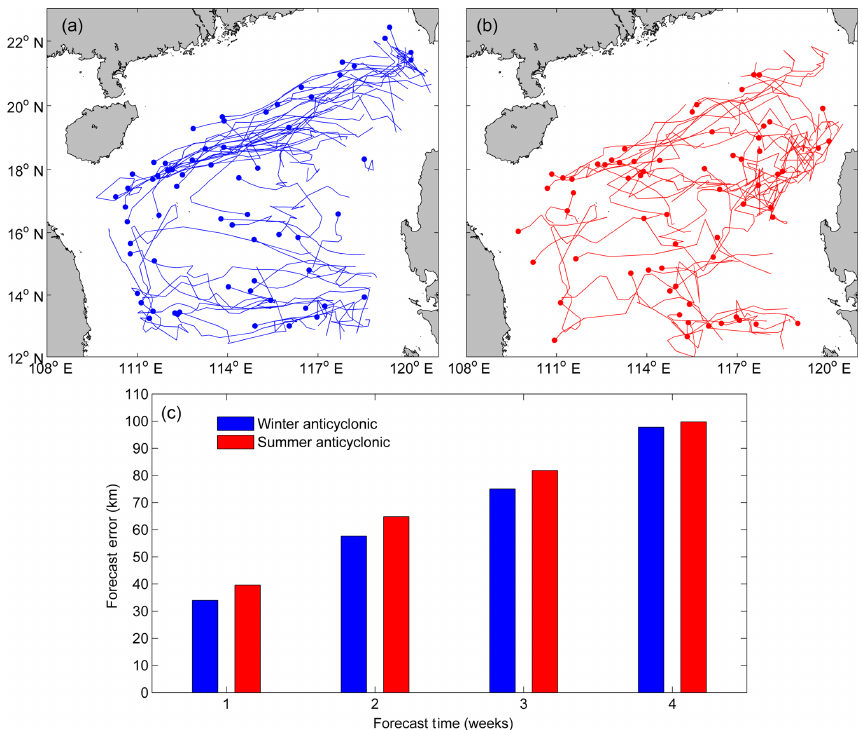
Figure 7. The trajectories of anticyclonic eddies in (a) winter and (b) summer with lifetime ≥ 5 weeks in the northern South China Sea. The solid circle represents the ending position of each trajectory. (c) Comparison of their mean forecast errors over a 4-week window.